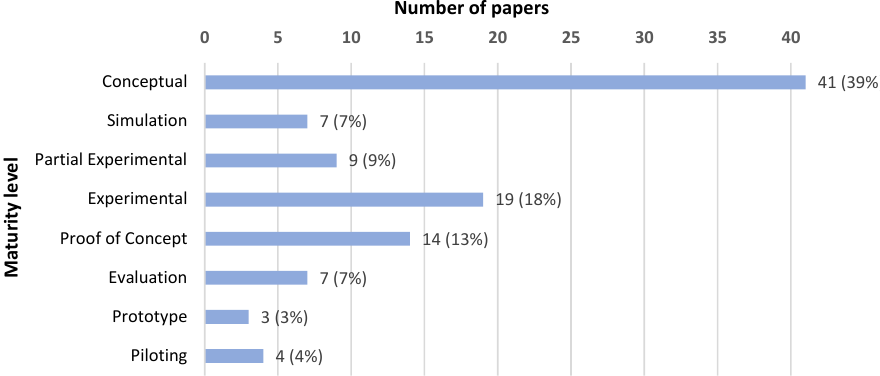
Figure 6. Maturity of the research presented in the papers included in our scoping review.